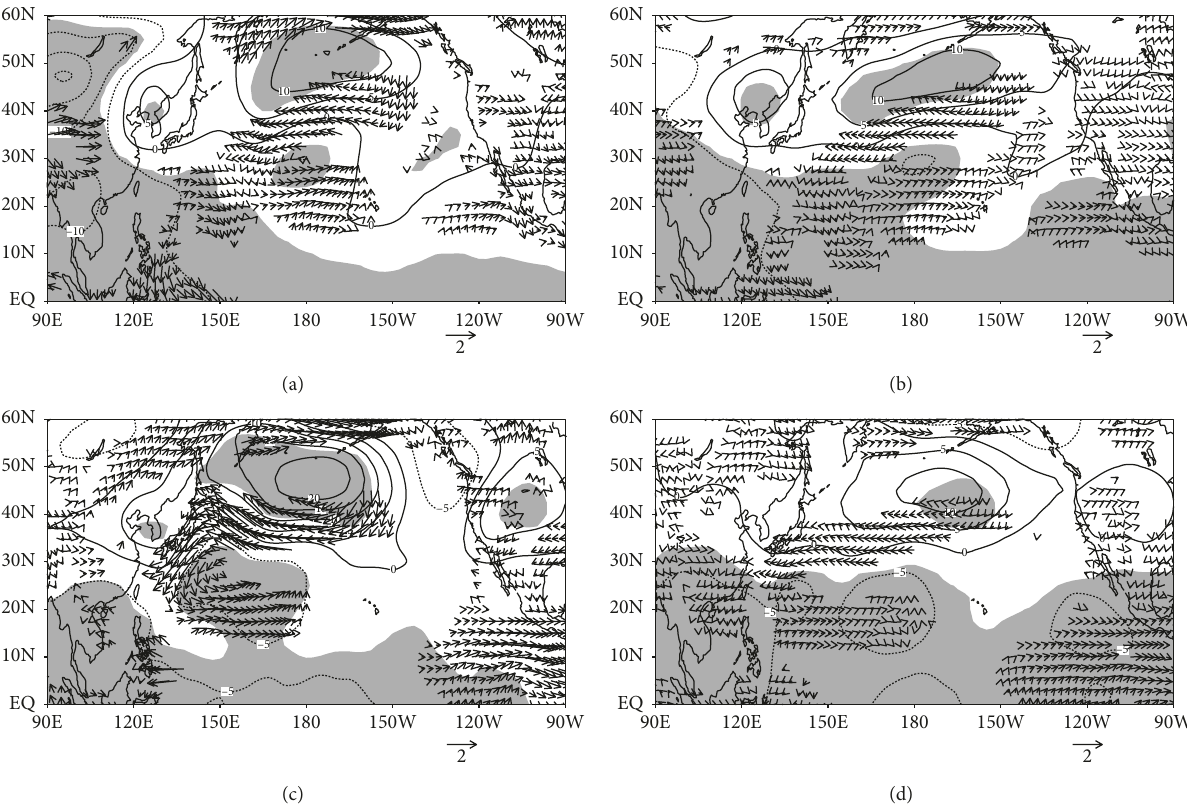
Figure 8: Regression maps of 850hPa wind and 500hPa GPH in (a) 1948–1990 and (c) 1991–2016 with regard to the APOI. Shaded area/ vectors indicate that the GPH/wind anomalies are significant at the 90% confidence level based on Student’s t -test. (b) and (d) are same are as for (a) and (c), but for the